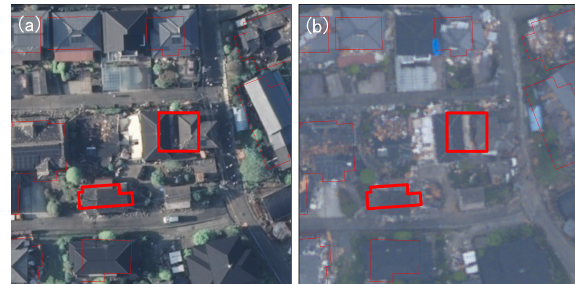
Figure 16. (a) Aerial image taken on 15 April; (b) aerial image taken on April 23. The thick red polygons show buildings that col- lapsed after the foreshock and were detected using the (cid:49)H thresh-